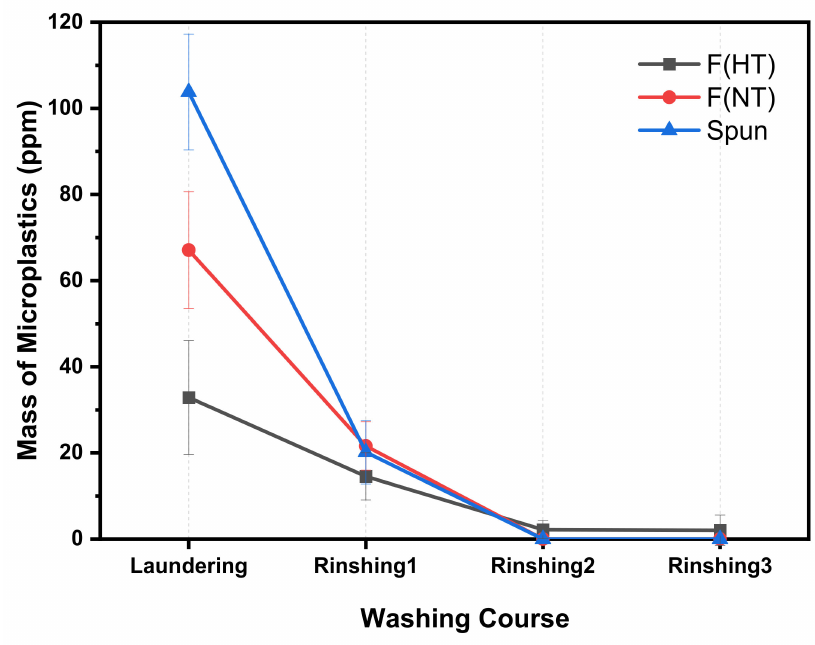
Figure 4. Amount of microplastics generated according to the laundering